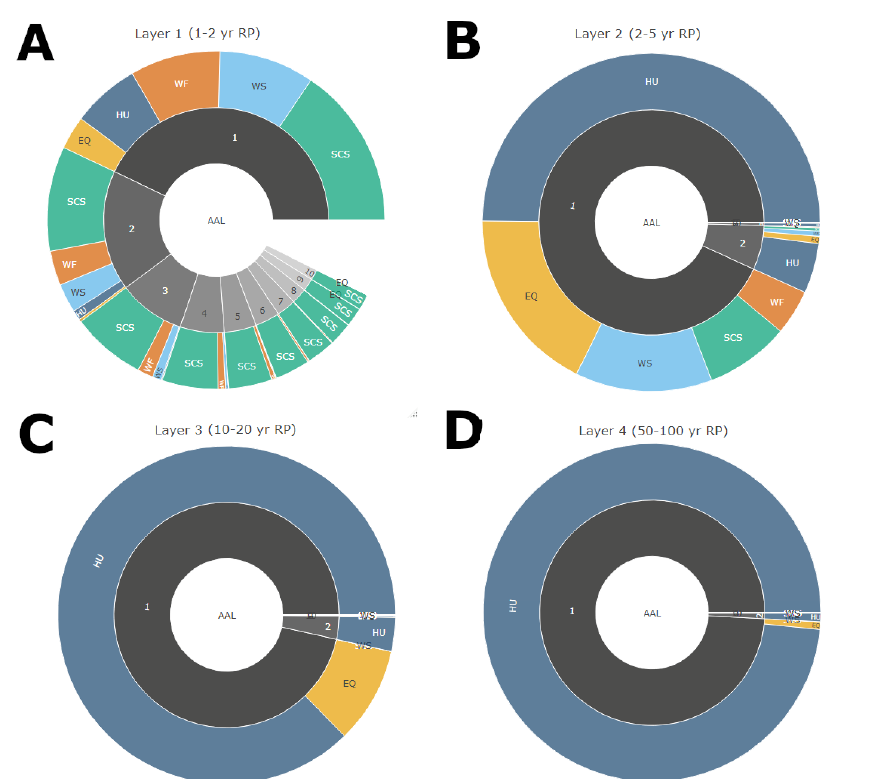
Figure 8. ( Panel A ) depicts the AAL decomposition for a catXL layer with attachment and exhaustion points defined by the loss thresholds of the M = 1 occurrence loss distribution (Figure 4 Panel C) for the 1 and 2 year return periods, respectively. The results displayed here are analogous to the pre-catXL results in Figure 5. ( Panels B – D ) show results for layers defined by return periods 2–5, 10–20 and 50–100 years,